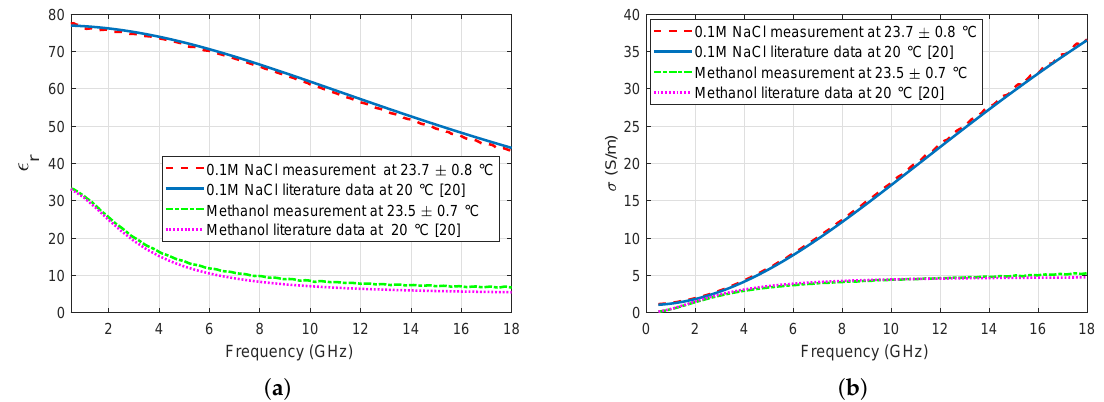
Figure 2. Comparison of measured reference liquids to literature data [20]: ( a ) Comparison of relative permittivity, ( b ) Comparison of conductivity.